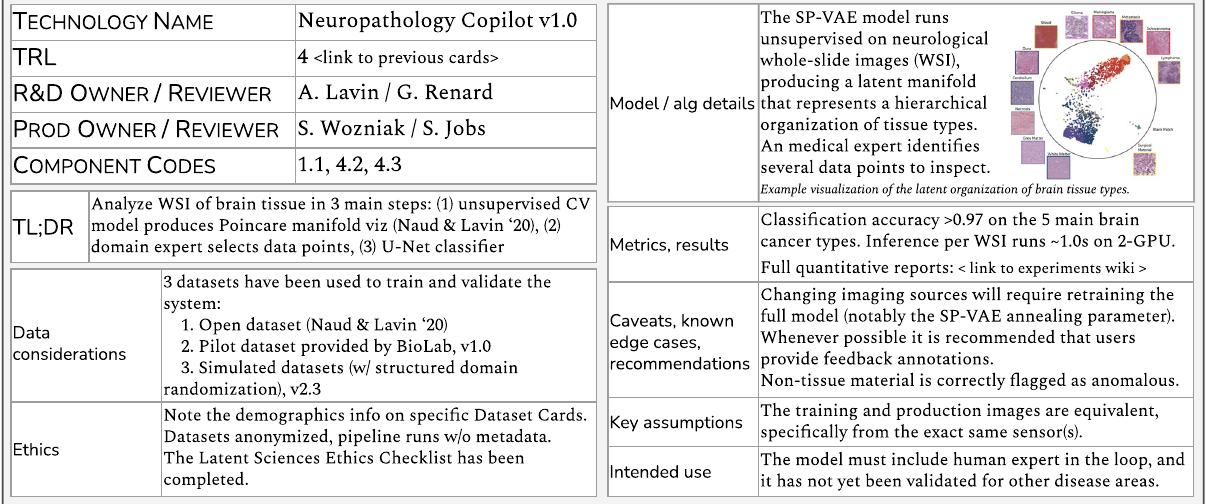
Fig.2|ThematurityofeachMLtechnologyistrackedvia TRLCards